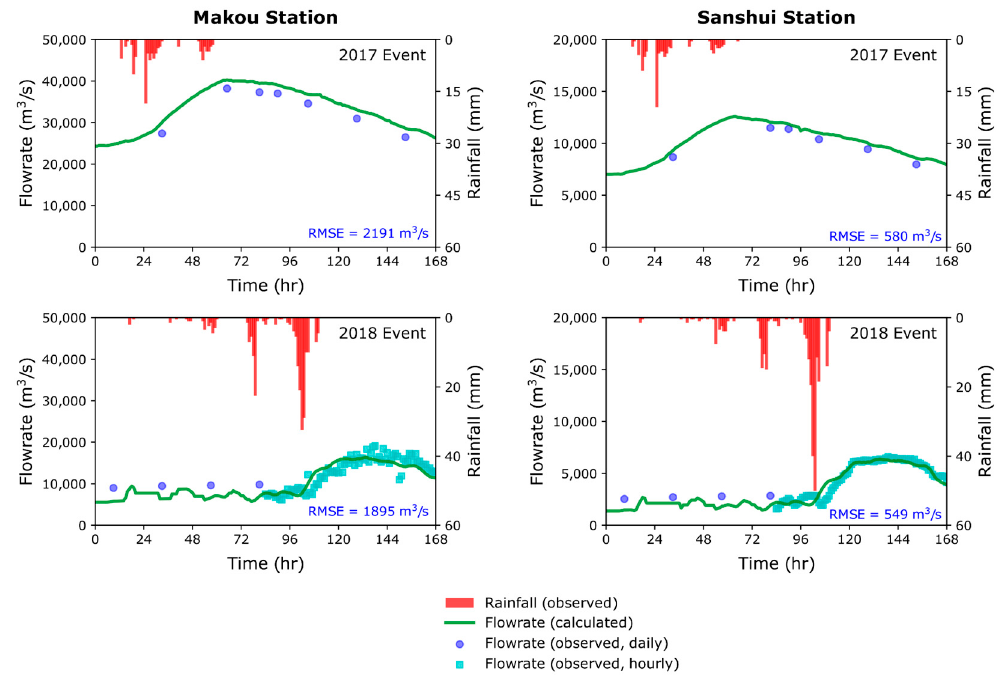
Figure 5. Time series of the incoming flowrate and rainfall at the inlet stations Makou and Sanshui for 2 to 8 July 2017 (top panel) and 4 to 10 June 2018 (bottom panel). The Root Mean Square Errors (RMSEs) are calculated using the combination of both daily and hourly observed flowrate data for the 2018 event.